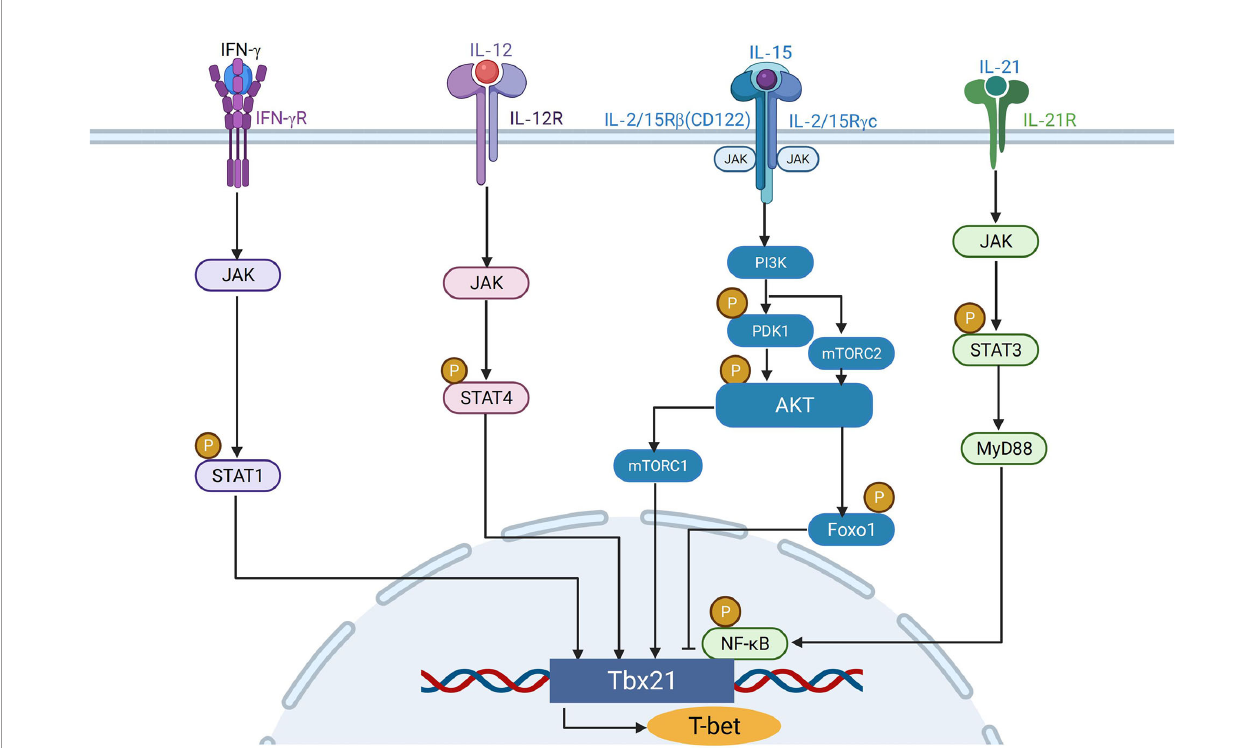
FIGURE 2 | The functions of T-bet in NK cells. T-bet promotes the transcription of genes including Prf1 , Gzmb and Runx1 to mediate NK cell cytotoxicity. T-bet positively regulates the secretion of IFN- g to regulate immune responses. Through inducing the expression of Zeb2, T-bet promoted the differentiation from immature NK cells to mature NK cells. T-bet induces Zeb2, and Zeb2 binds to the S1pr5 promoter which promotes mature NK cells egress from lymph nodes and bone marrow to peripheral